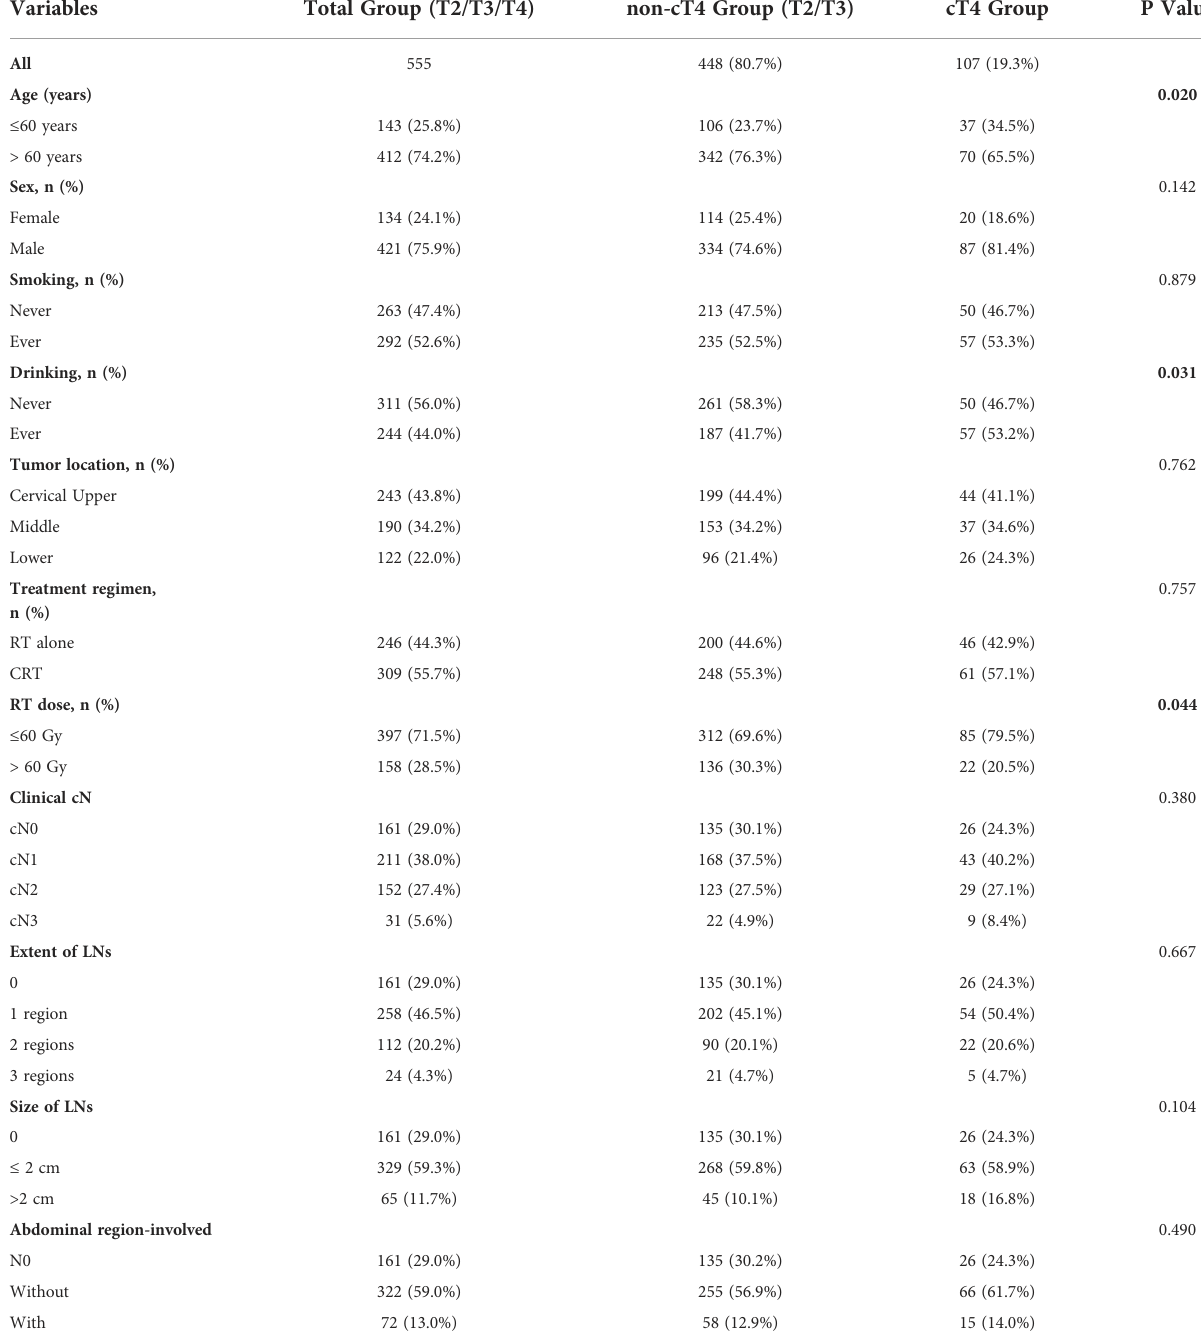
TABLE 1 Total group (cT2-4) patients ’ characteristics of prognostic